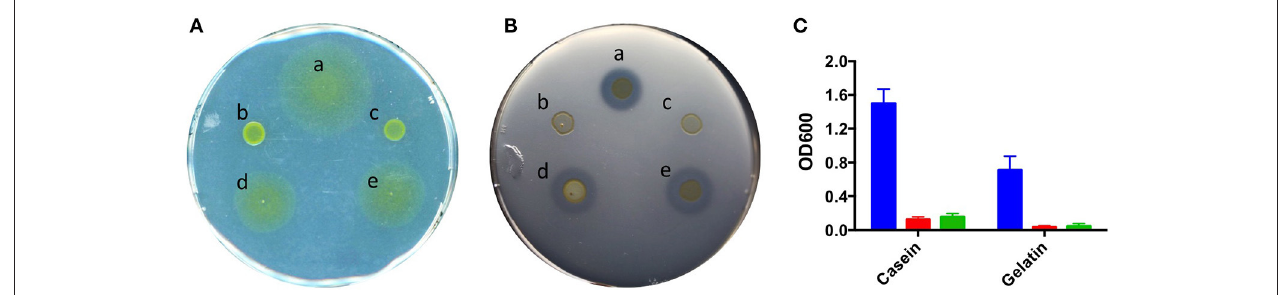
FIGURE 2 | Spreading and extracellular proteolytic activity. (A) Spreading of five different strains of F. psychrophilum grown on 1/5 TYES agar after 72h at 18 ◦ C: a, THCO2-90; b, gldG::Tn ; c, gldD::Tn; d , gldG::Tn pCP Gm R - gldG ; e , gldD::Tn pCP Gm R - gldD . (B) Extracellular proteolytic activity of the same strains grown on TYES agar + 0.75% gelatin after 72h at 18 ◦ C. (C) Growth of strains THCO2-90 (blue), gldG::Tn (red), and gldD::Tn ( green) in BH minimal broth medium supplemented with 0.5% of casein or gelatin after 72h at 18 ◦ C, 200 rpm. The results are representative of three independent experiments.